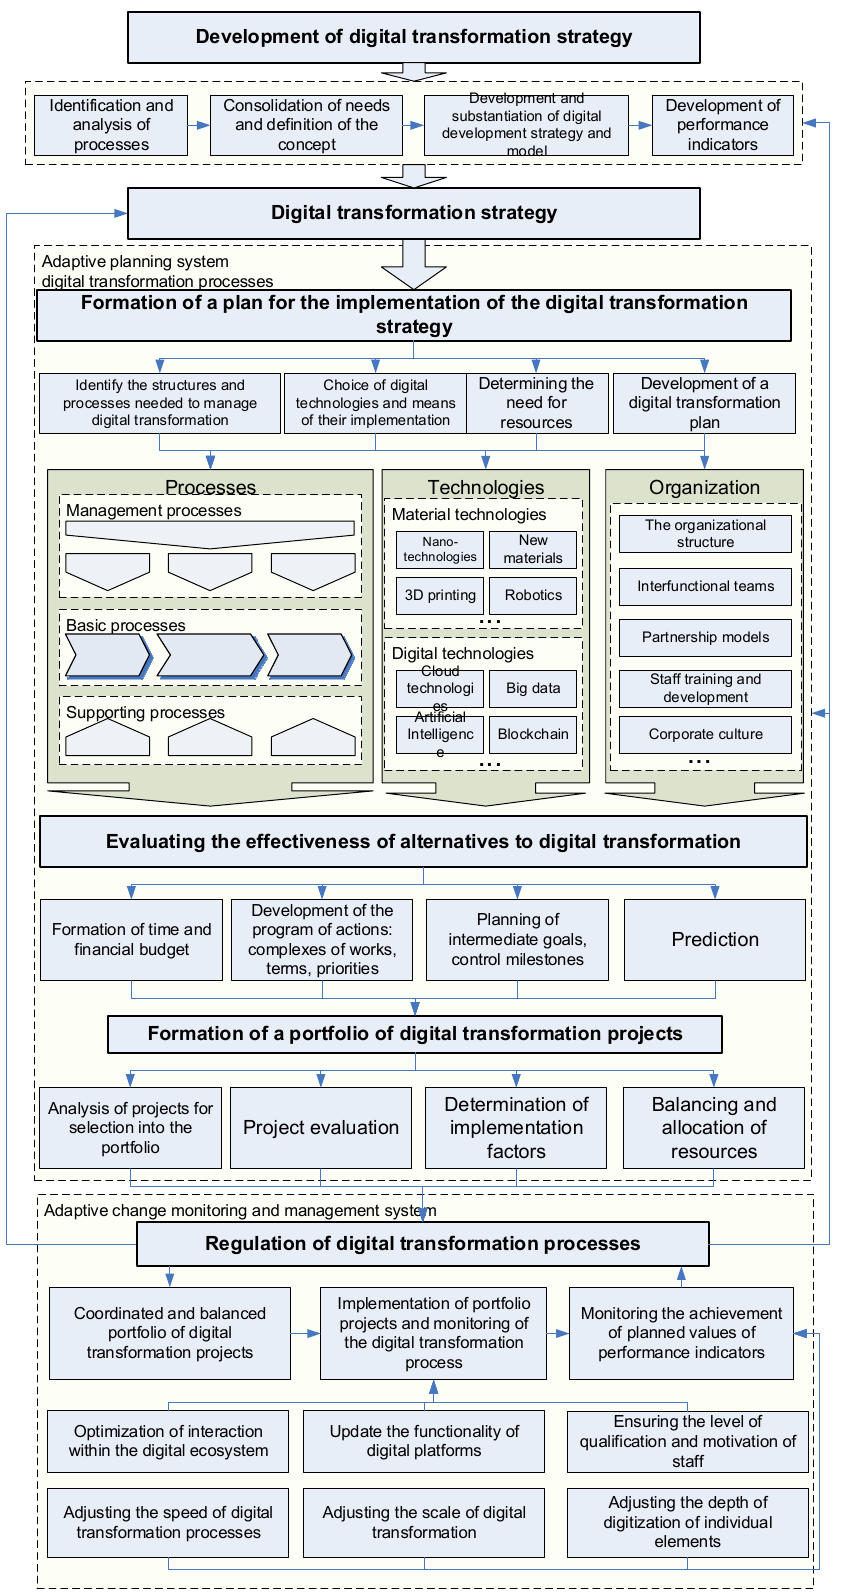
Figure 5. Multi-level model of digital transformation management in a high-tech enterprise. Source: own study.